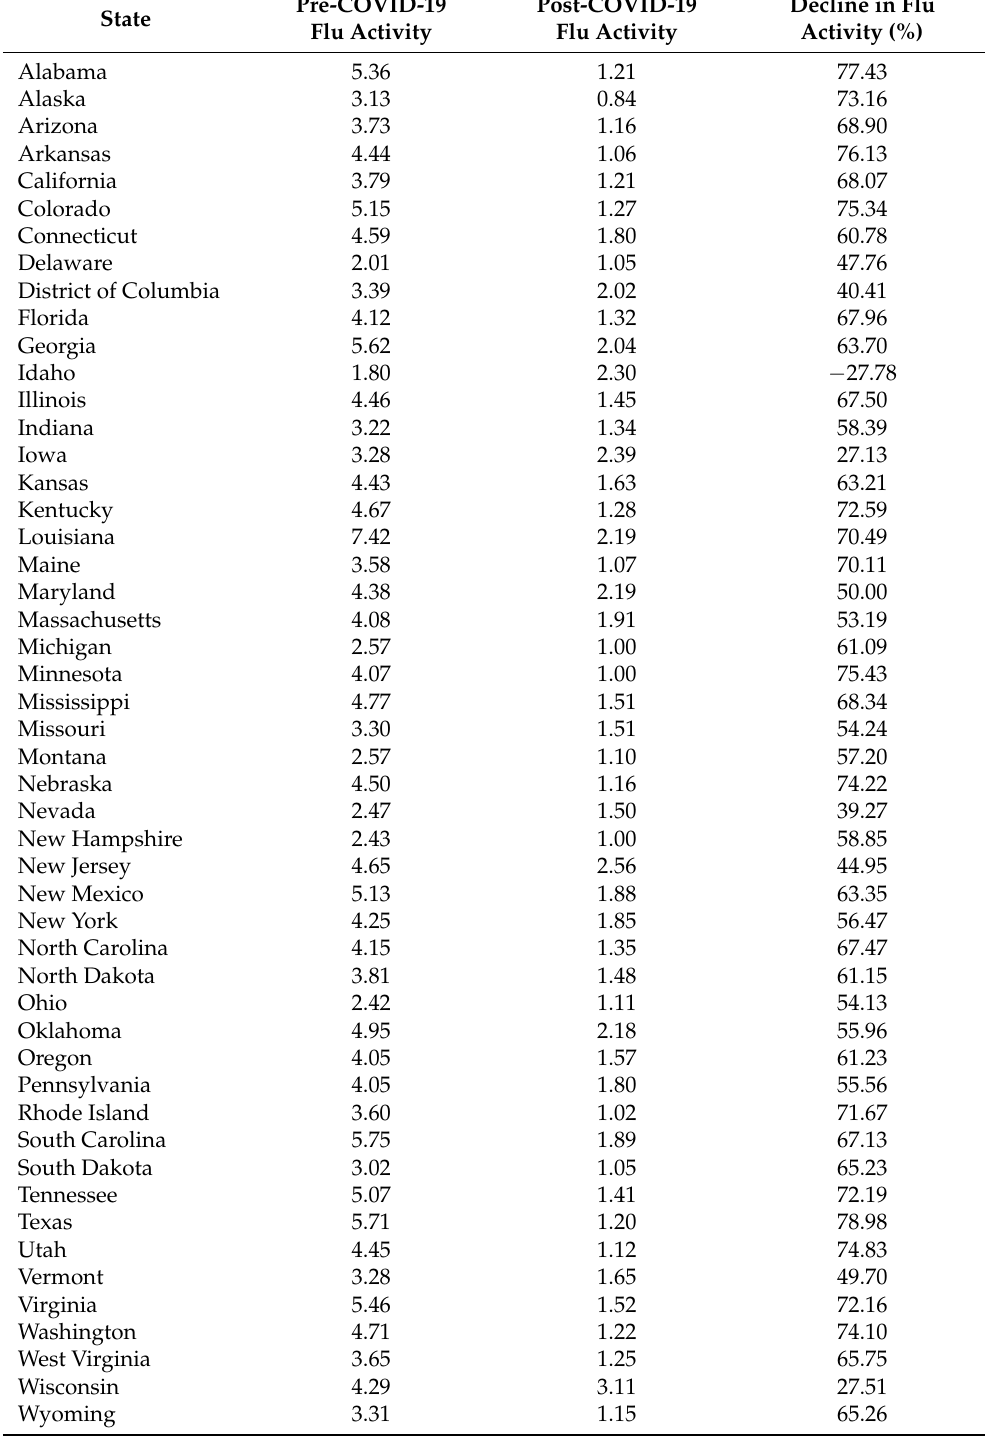
Table 1. Pre-COVID-19 (from April 2019 to March 2020), post-COVID-19 (from April 2020 to March 2021), and percentage decline in flu activity between the US